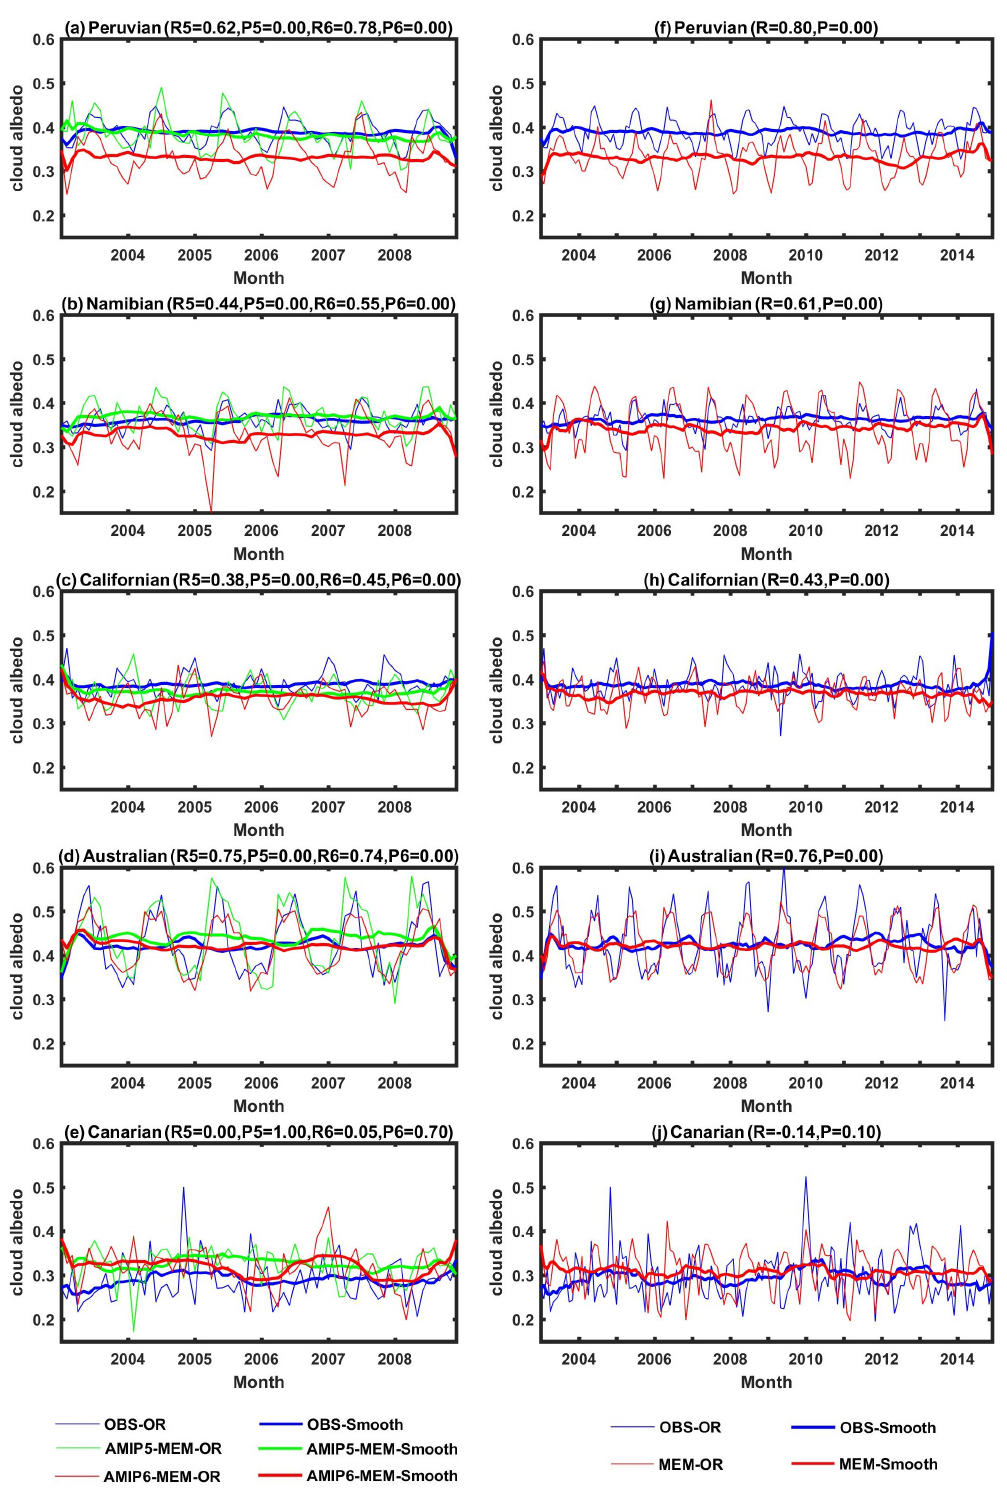
Figure 3. Monthly mean time series of estimated cloud albedo (a–e) from AMIP5 and AMIP6 multimodel ensemble mean during 2003– 2008 and (f–j) from AMIP6 multimodel ensemble mean during 2003–2014 compared with satellite observations over the (a, f) Peruvian, (b, g) Namibian, (c, h) Californian, (d, i) Australian and (e, j) Canarian regions.